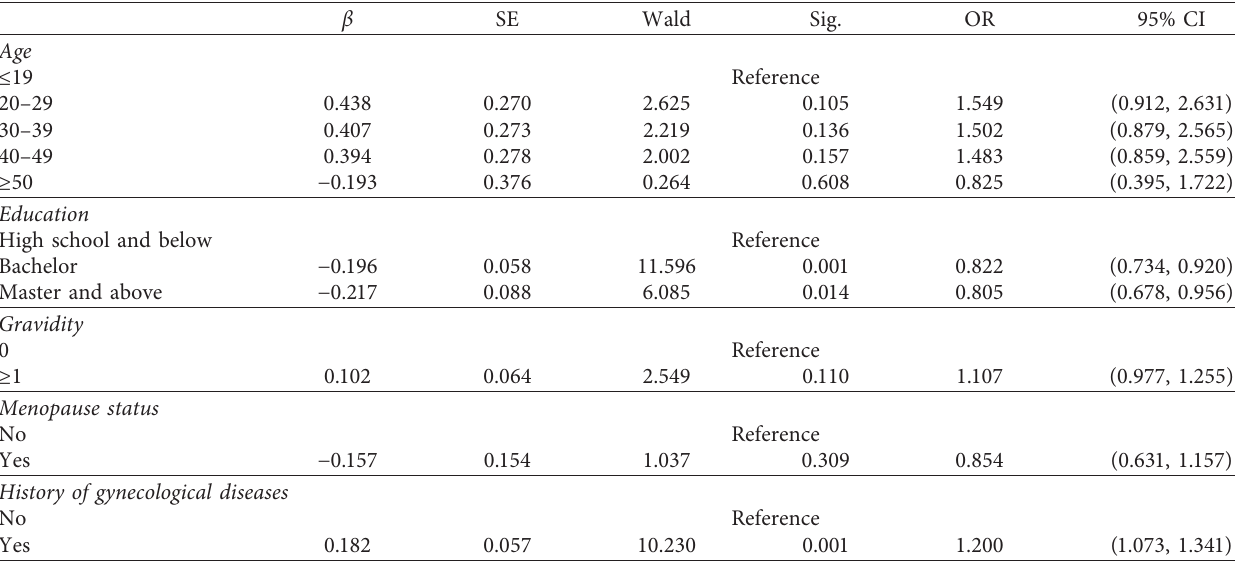
Table 2: Multivariate logistic regression analysis of risk factors for Mycoplasma isolation.